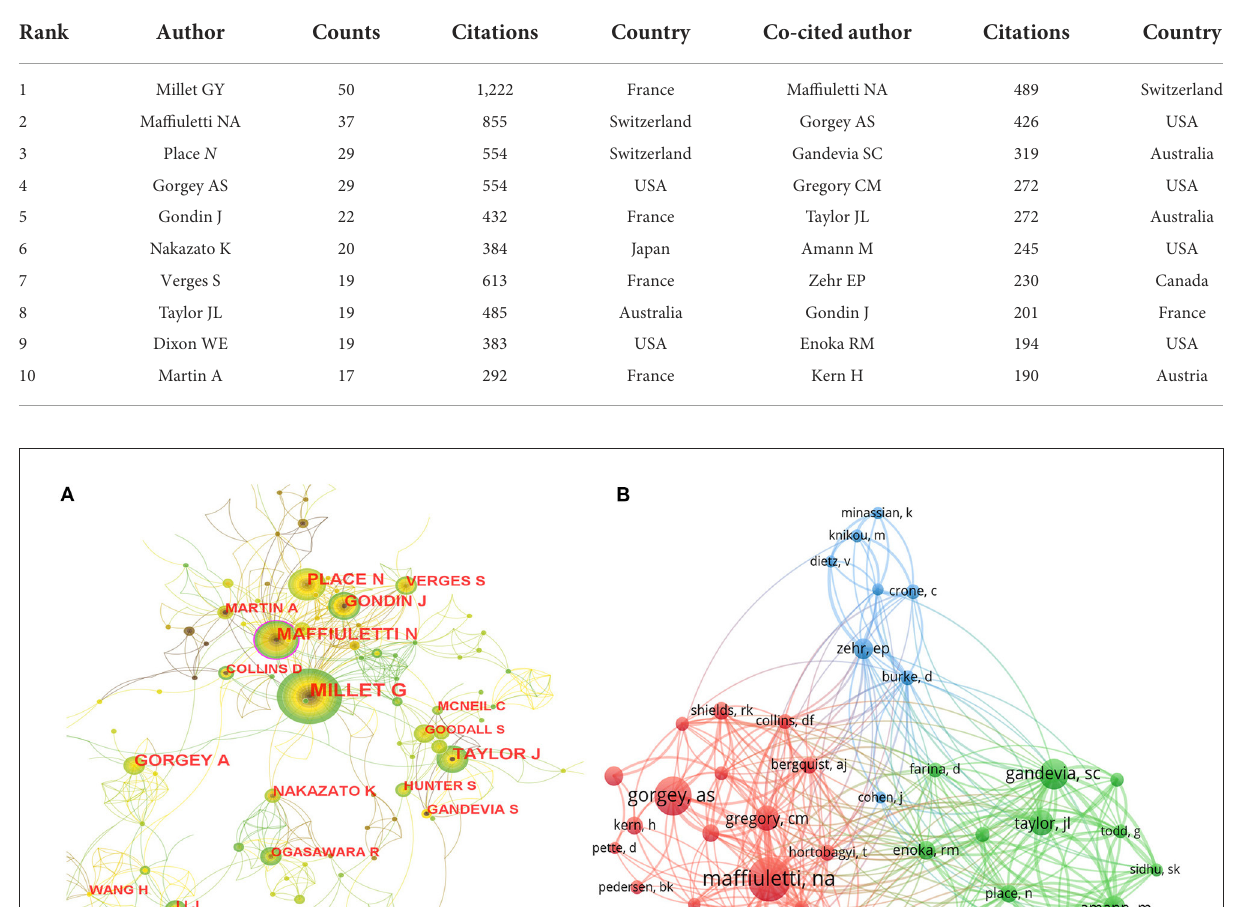
TABLE 3 The top 10 prolific and co-cited authors from 2011 to 2021.